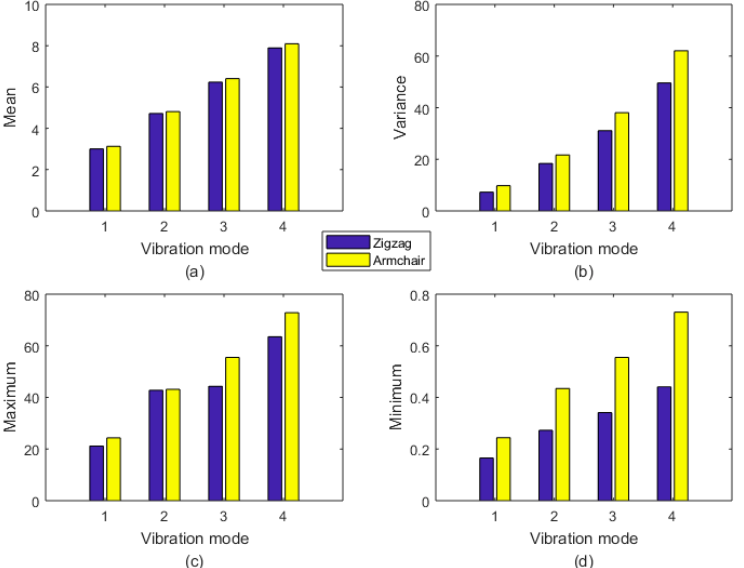
* F 1 -F 4 represent the first-fourth natural frequencies. Z and A are for Zigzag and Armchair graphene sheets, respectively.